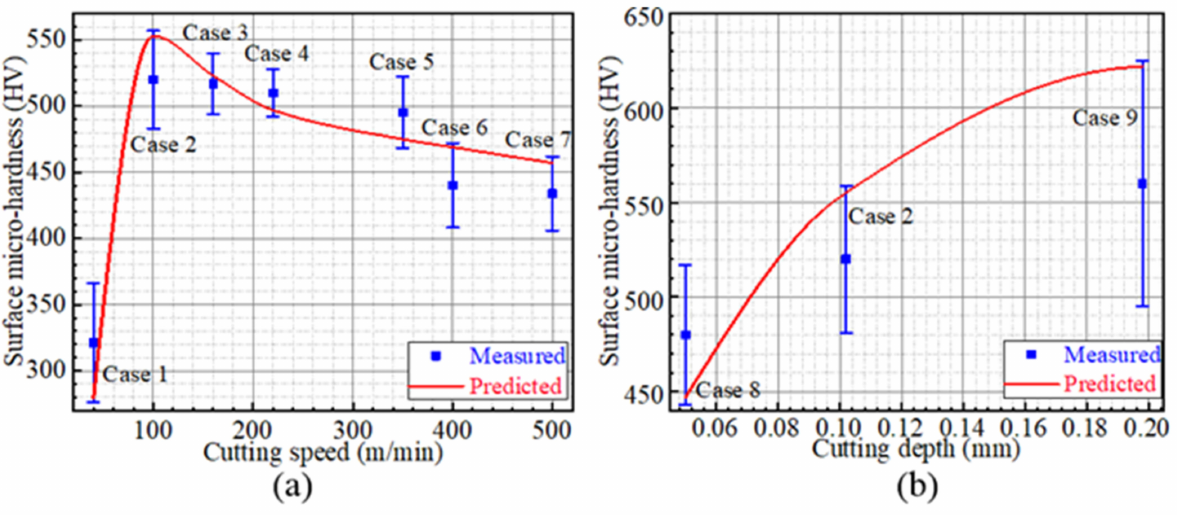
Figure 16. The surface microhardness curves: ( a ) The relationship between micro-hardness and cutting speed, ( b ) The relationship between micro-hardness and cutting